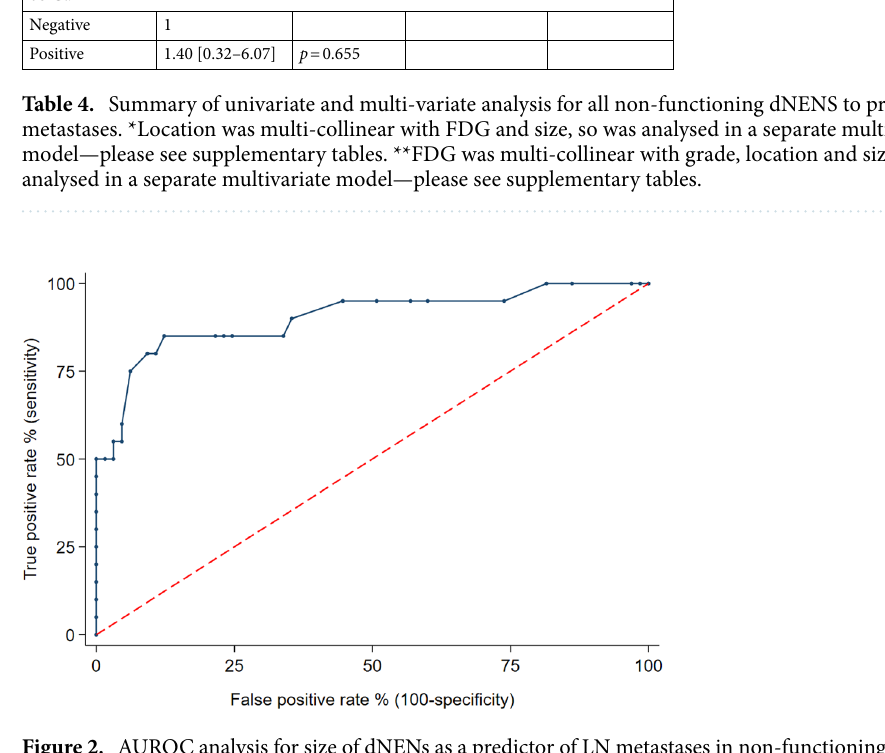
Figure 2. AUROC analysis for size of dNENs as a predictor of LN metastases in non-functioning d